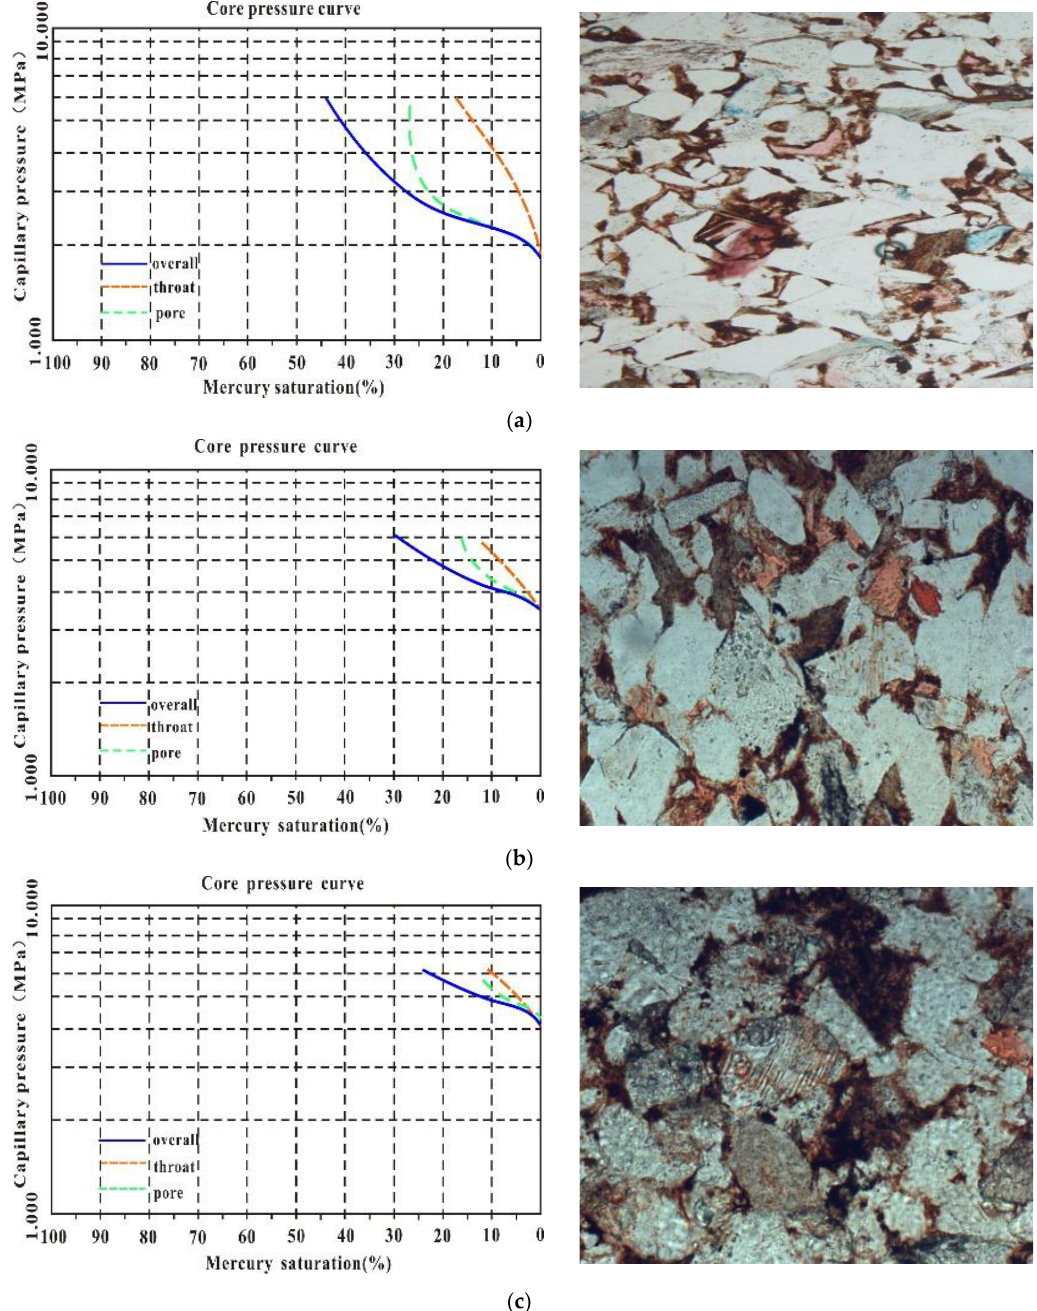
Figure 1. Reservoir space and capillary-pressure curve characteristics of different reservoirs. ( a ) No.6, 1943.9 m, macro pore-thin throat, intergranular pores and dissolved pores are developed; ( b ) No.1, 2187.3 m, macro pore-fine throat, dissolved pores, a few intergranular pores and micro pores were developed; ( c ) No.3, 2148.79 m, macro pore-micro throat, micro pores and a few dissolved pores were developed.